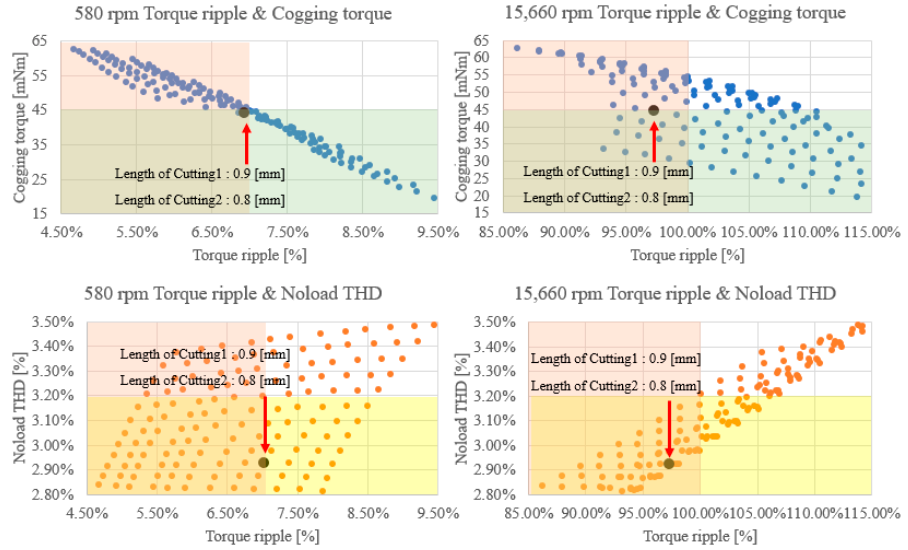
Figure 7. Results of the first 2D finite element analysis at washing and dehydrating load.